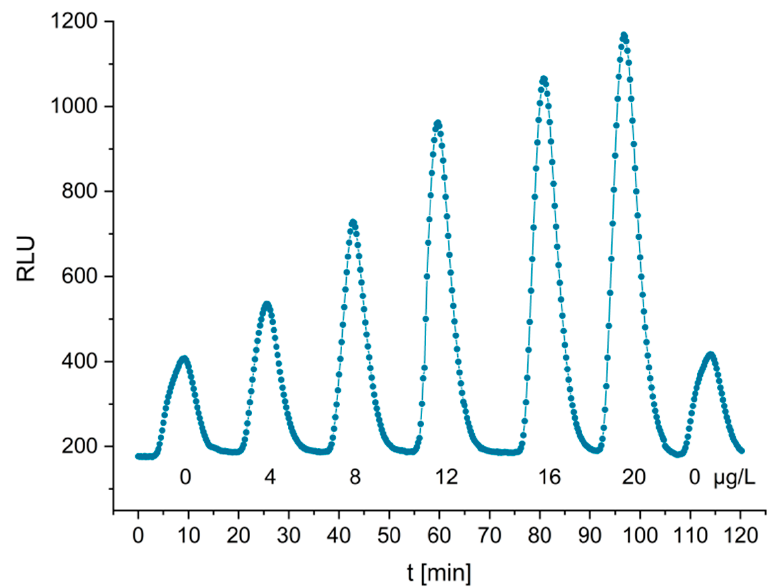
Figure 12. Measurement of human plasma, diluted 1:40 in running buffer and spiked with rec. cTnI in a range between 0 and 20 µg/L. The dilution factor is not included in the given concentrations. The calibration lines for cTnI in serum and plasma are shown in Figure 13. With a dilution of 1:40, no concentration-dependent matrix effects were observed. The experiment covered a range between 0 and 800 µ g/L of spiked recombinant cTnI. LoDs of 70 µ g/L for serum and 60 µ g/L for plasma were calculated based on the standard deviations of the blank values of each dilution series, including the 40-fold dilution factor.